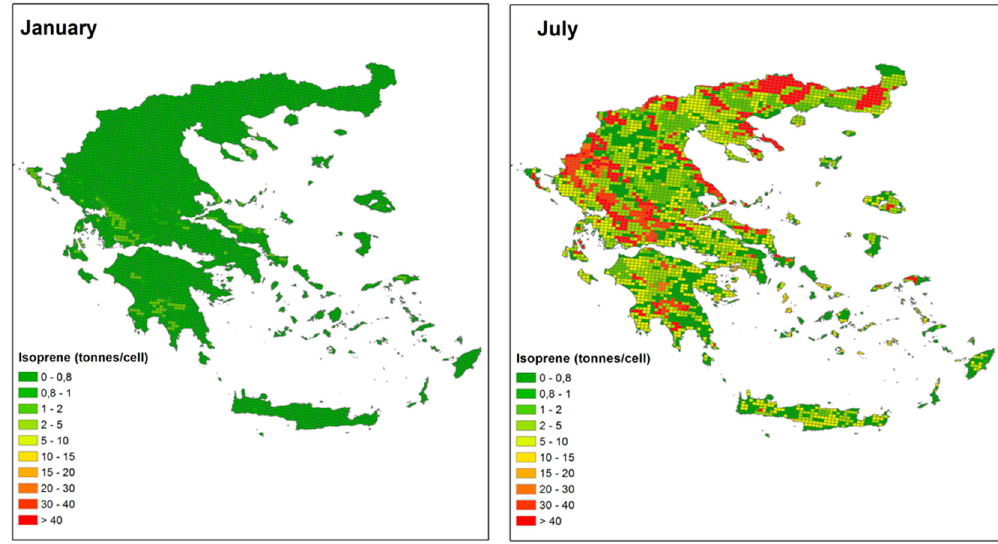
Figure 5. Monthly isoprene emissions in January and in July.